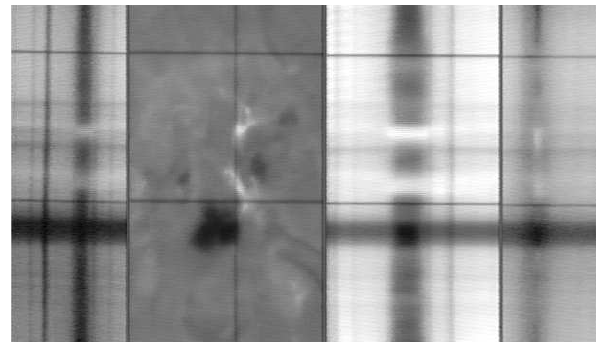
Fig. 4. The MFS composed observation of the two flare kernels at 10:04:19UT – during the third rise of the X-ray. H α emission profiles became a standard form again.